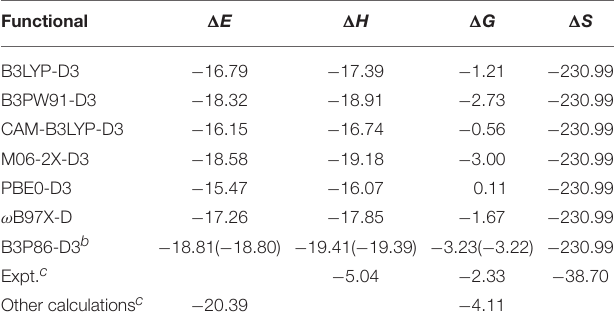
TABLE 2 | Binding energies ( 1 E) , binding enthalpies ( 1 H) , binding Gibbs free energies ( 1 G) , and binding entropies ( 1 S) for conformer 1 computed with different functionals [energies in kcal/mol, entropies in J/(K • mol)] a